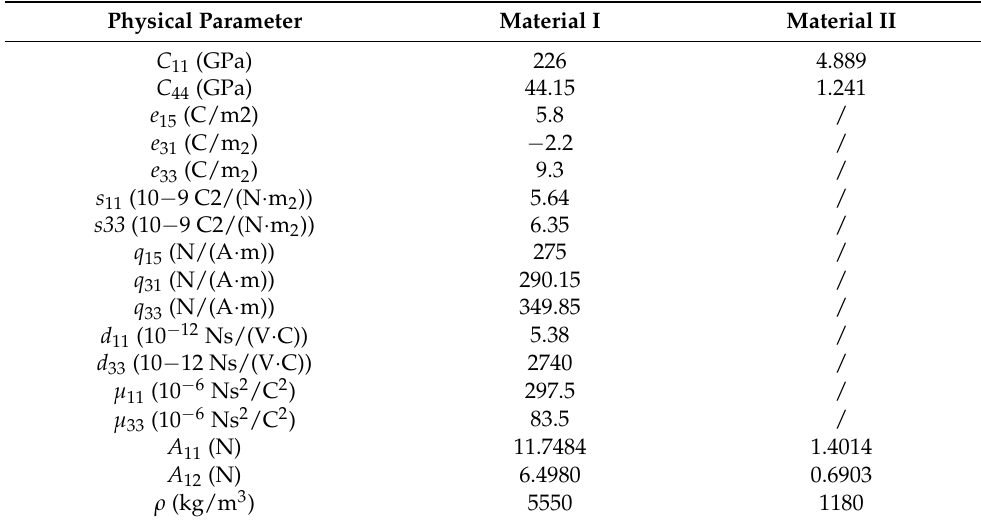
Table 1. The properties of material I and material